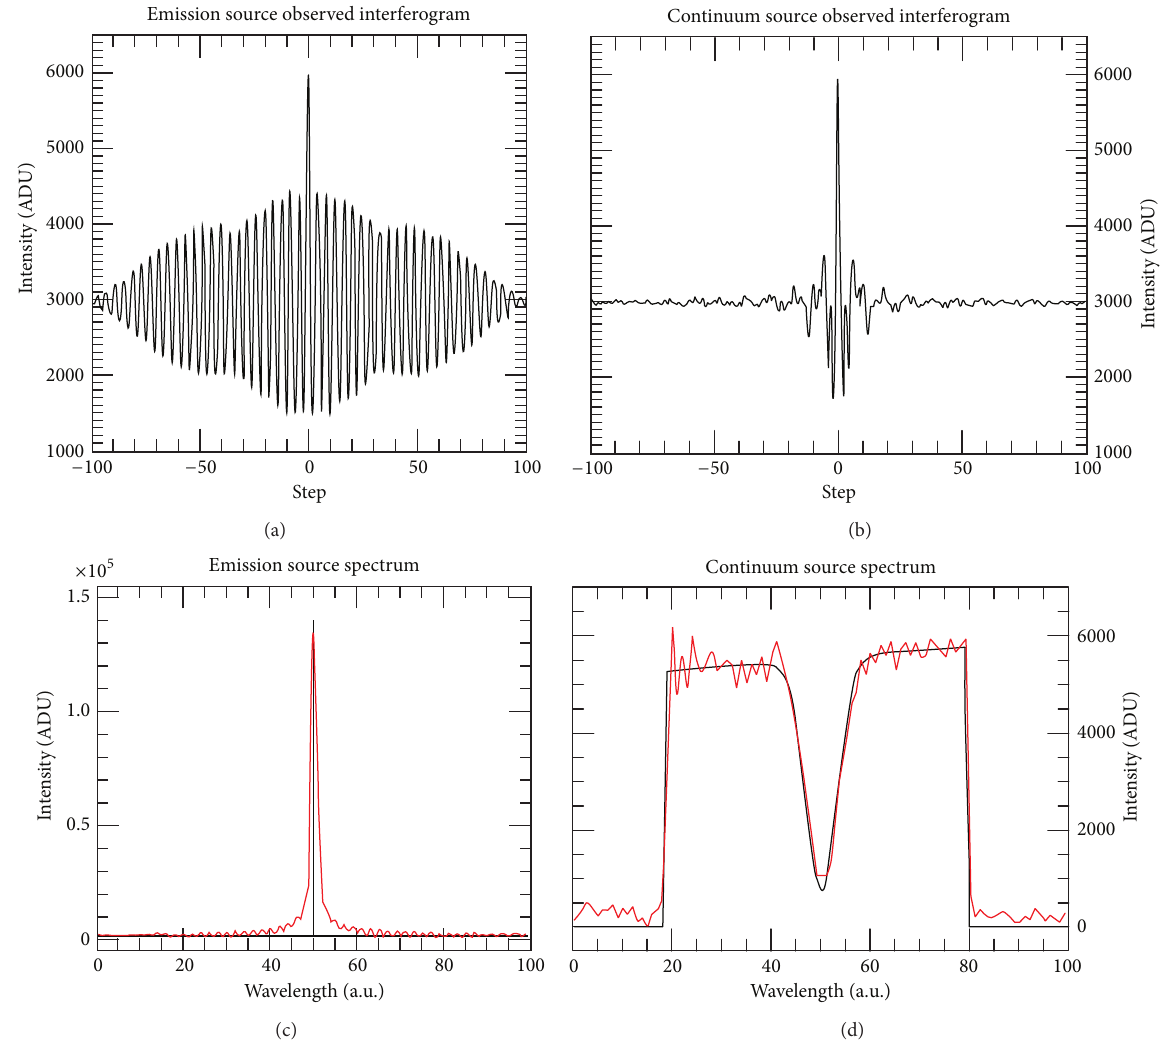
Figure 10: Comparison between simulated emission and absorption lines spectra.